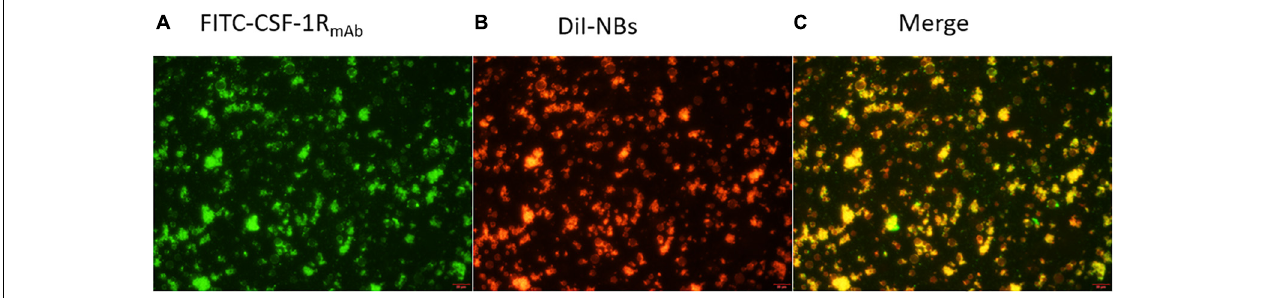
FIGURE 4 | Fluorescence microscopy image of target NBs. (A) CSF-1R mAb (FITC showed green fluorescence), (B) DiI-dyed (nanobubbles showed red fluorescence), and (C) their co-localization (merge) under fluorescence microscope, with a sale bar of 200 µ m.